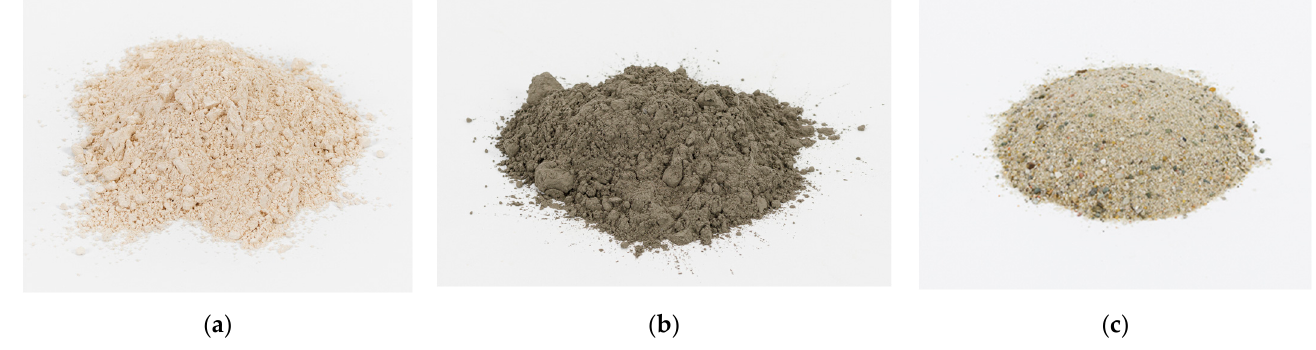
Figure 1. Used raw materials for geopolymer mortar: ( a ) metakaolin; ( b ) fly ash; ( c ) river sand (fine aggregate).